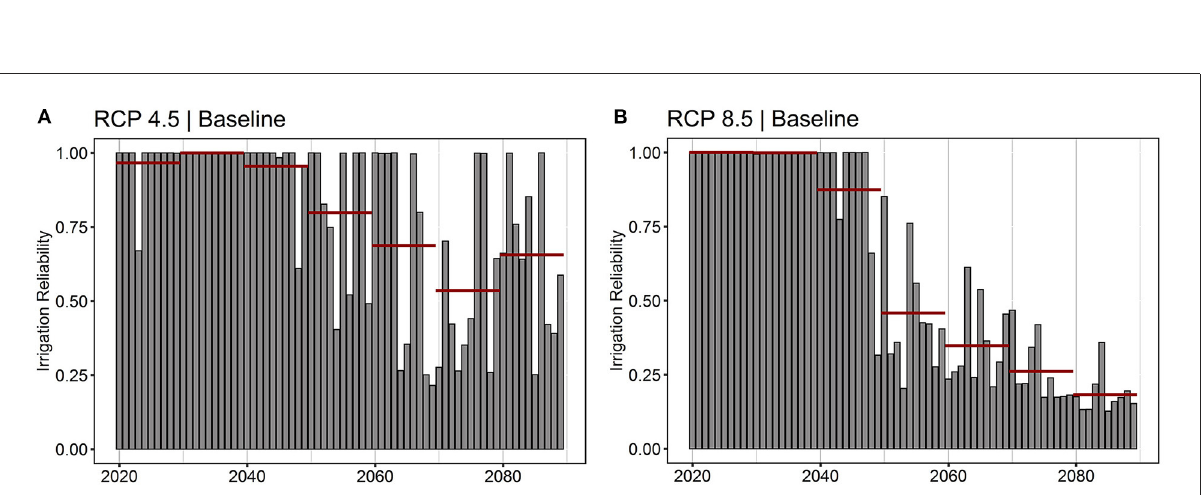
FIGURE6 Annual irrigation reliability for (A) RCP 4.5 and (B) RCP 8.5. The red lines are the average irrigation reliability value for each CC. Lower irrigation reliability means there is not enough agricultural water supply to meet